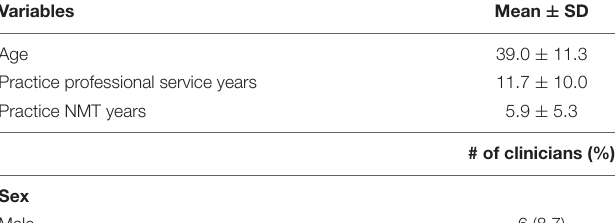
Table 3 indicates the total techniques implemented for NMT